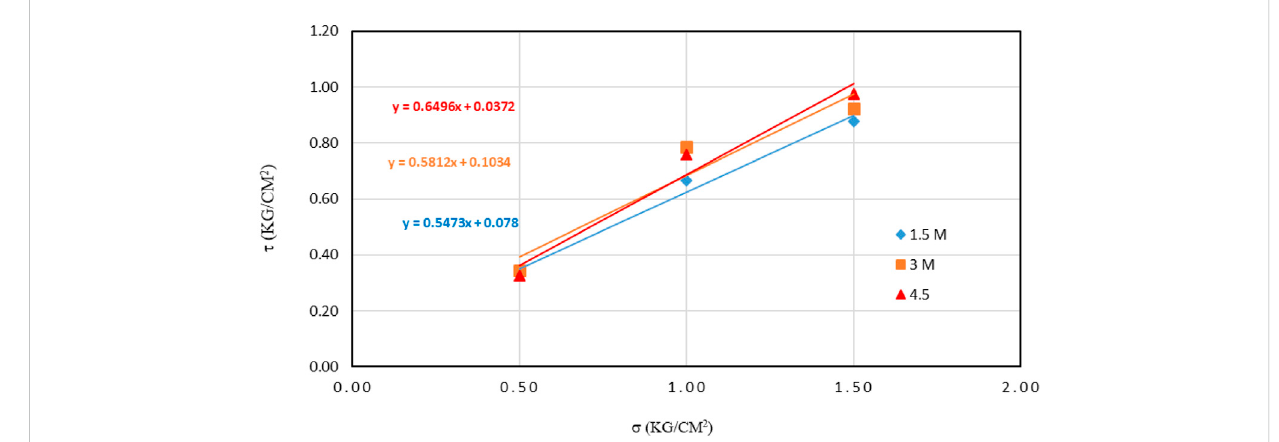
FIGURE 11 Shear strength results for treated soil with 20% of NaCl at different